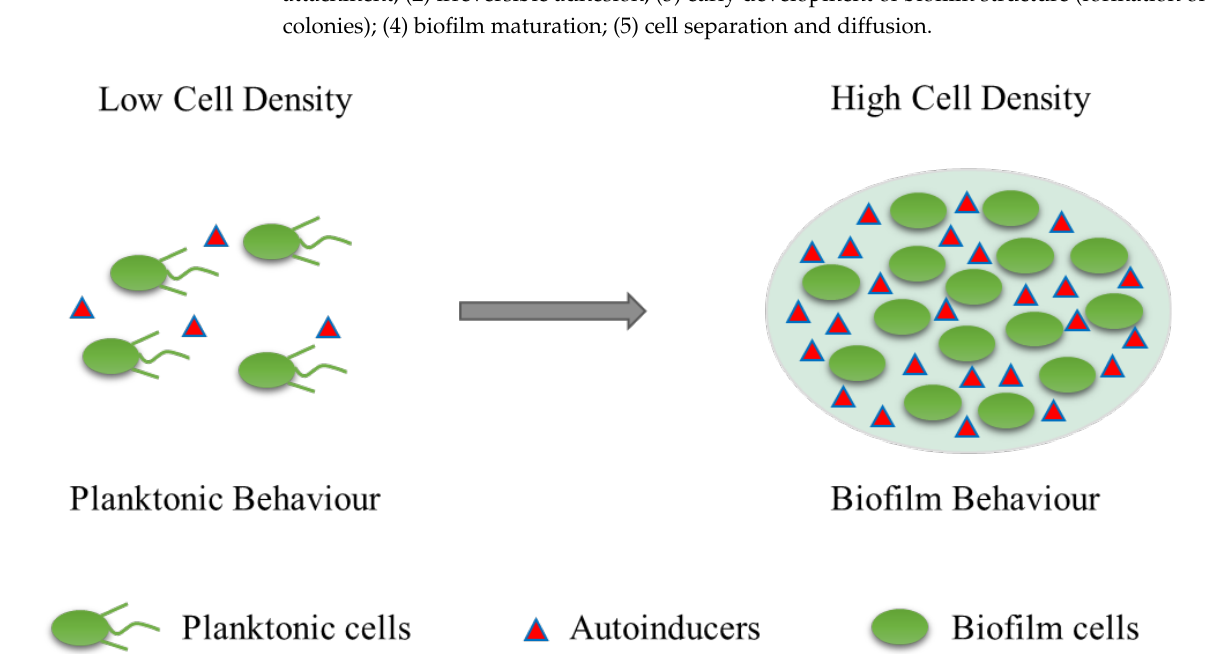
Figure 2. Quorum sensing (QS) illustration. Autoinducer is a signaling molecule. These autoinducers are continuously produced by bacterial cells, so the level of autoinducers increases as the cell number increases.